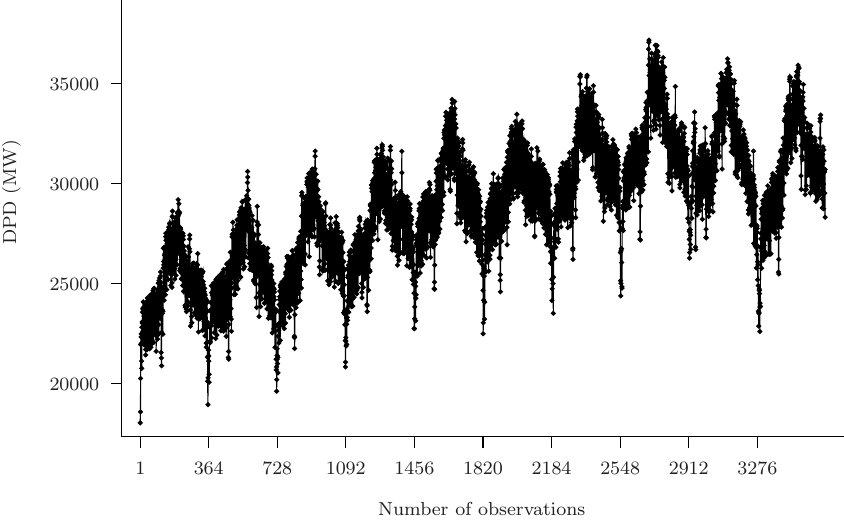
Figure 1: Time series plot of daily peak electricity demand for the period 1/1/2000 to